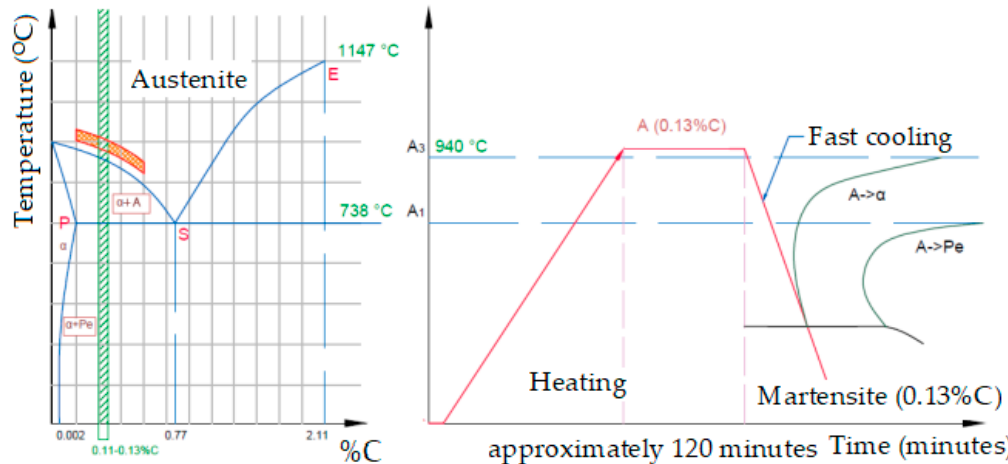
Figure 1. The heating range and the cycle of operations for tempering the semi-finished products [1].